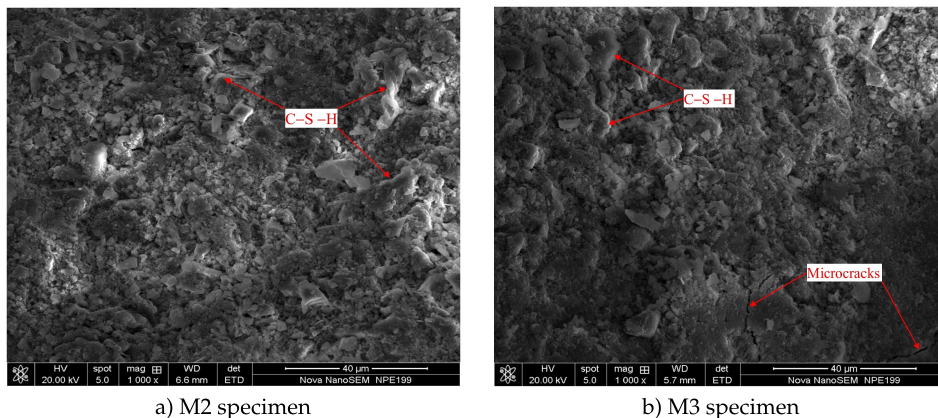
Fig. 11. Hydration products morphology of M2 and M3